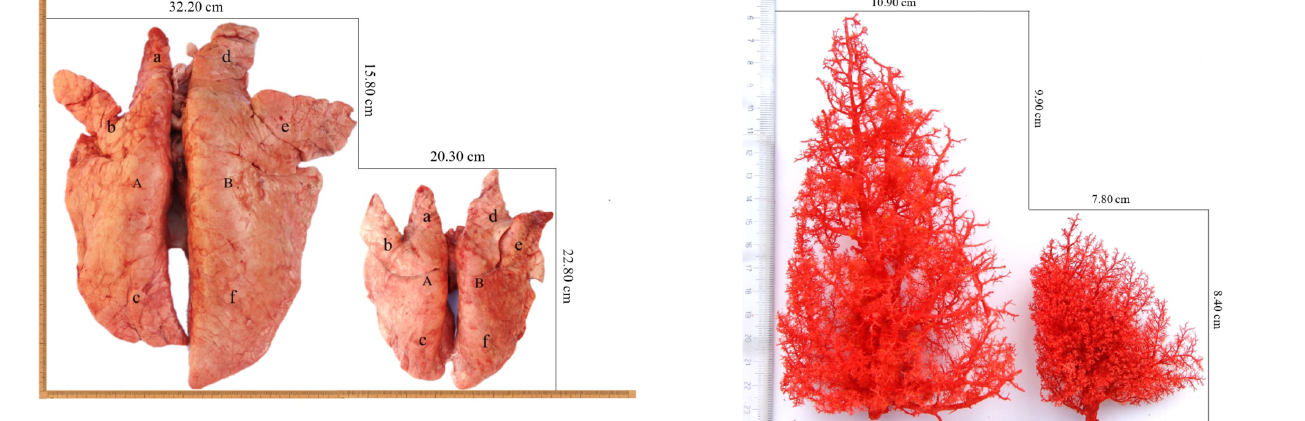
Figure 1. The lungs of Tibetan pigs (right) and Landrace pigs (left). A: left lung; B: right lung; a: left anterior lobe; b: left middle lobe; c: left rear lobe; d: right anterior lobe; e: right middle lobe; f: right rear lobe.